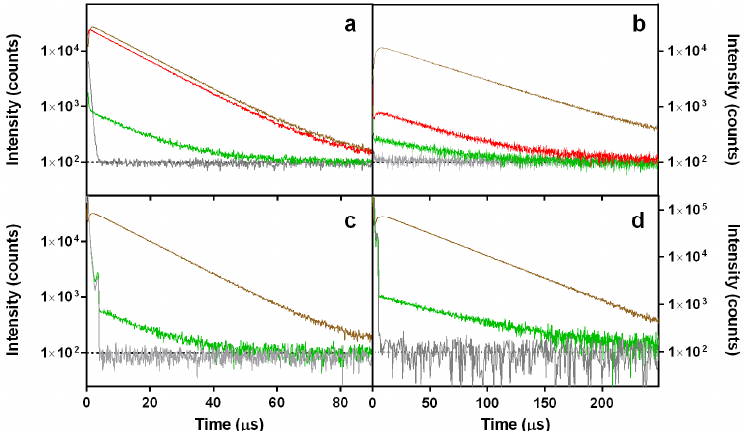
Figure 5. Singlet oxygen phosphorescence kinetics at 1275 nm in EtOH ( a , c ) and D 2 O ( b , d ) solutions of DOXO (green), PhA (red) and reference photosensitizers (PSs) (brown). The signals completely disappeared in the presence of 25 mM NaN 3 , a typical 1 O 2 quencher (grey). Rose Bengal (RB) in EtOH and flavin mononucleotide (FMN) in D 2 O were used as references. The excitation wavelength was 532 nm for ( a , b ) and 473 nm for ( c , d ).